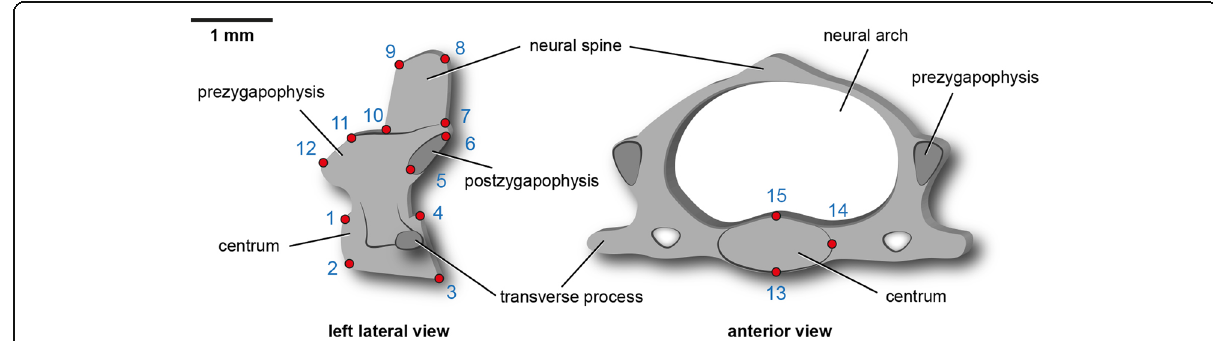
Fig. 1 Landmark set used in the 3D geometric morphometric analysis. The numbered 3D landmarks ( red points ) are shown on a schematically illustrated mid-cervical vertebra of Mus musculus . Detailed definitions of the 15 homologous points are provided in Table